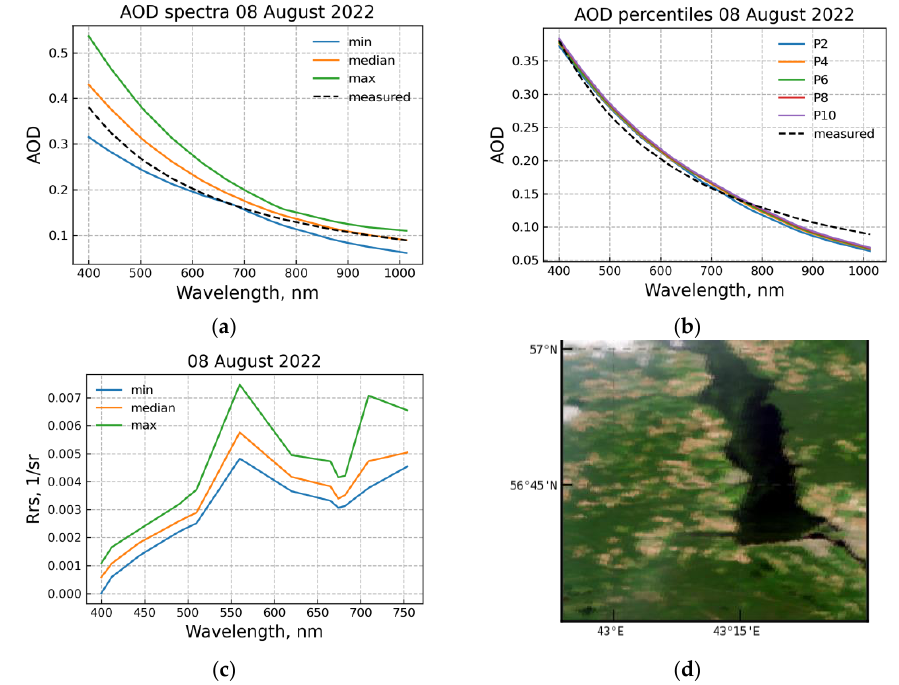
Figure 8. AOD and R rs spectra retrieved from the Sentinel-3B/OLCI image for 8 August 2022: ( a )